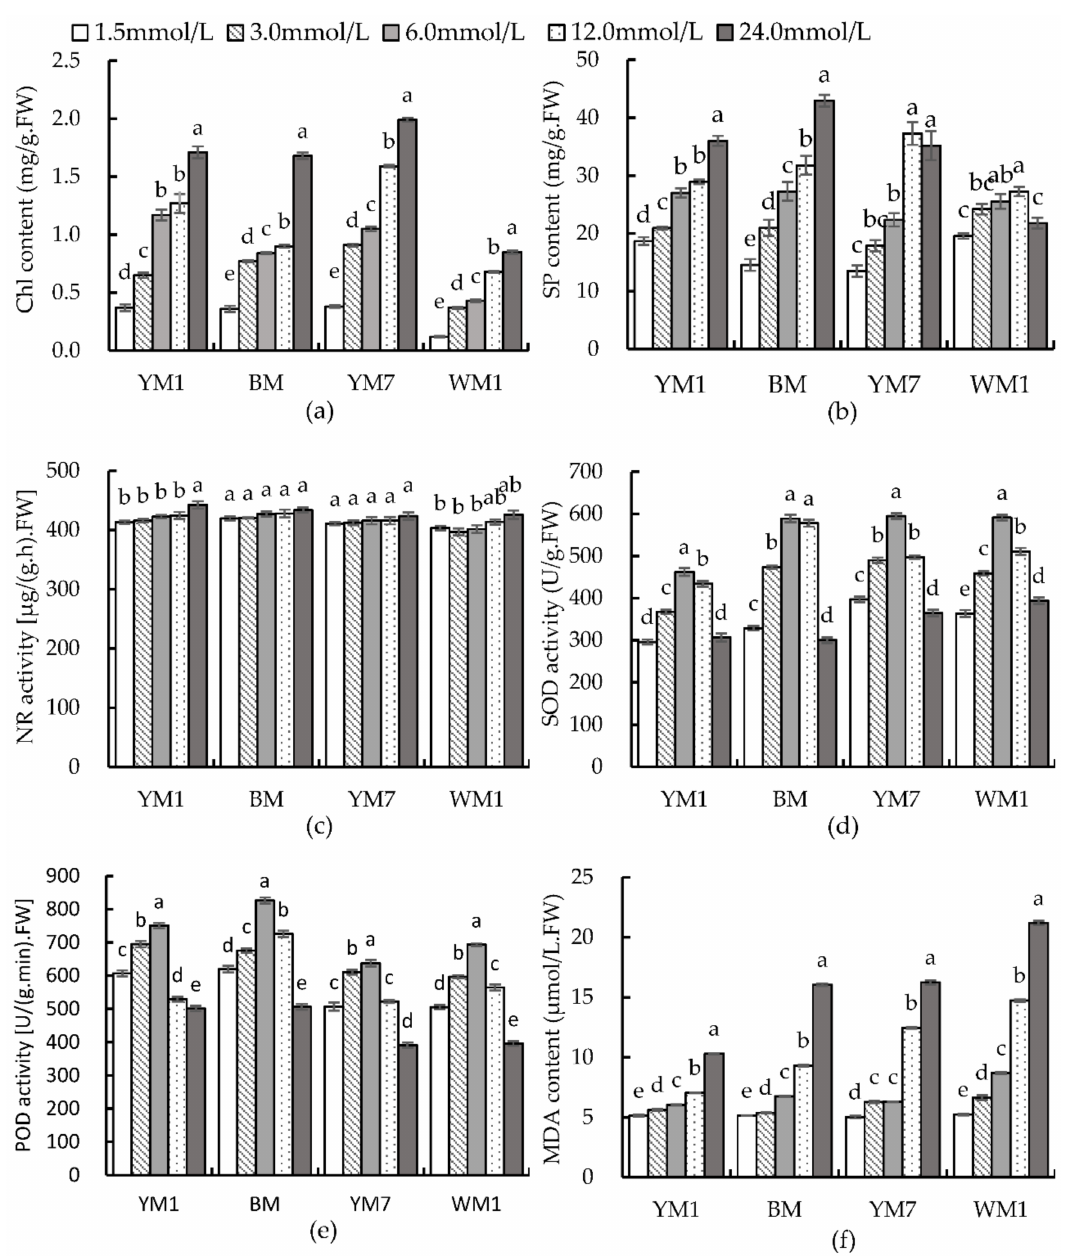
Figure 4. Effect of N treatments on the physiological indicators of hemp leaf. Different letters above the columns within a cultivar represent significant differences in physiological indicators of leaf at p = 0.05. ( a ) The content of Chl of four hemp cultivars under different levels of N. ( b ) The content of SP of four hemp cultivars under different levels of N. ( c ) The activity of NR of four hemp cultivars under different levels of N. ( d ) The activity of SOD of four hemp cultivars under different levels of N. ( e ) The activity of POD of four hemp cultivars under different levels of N. ( f ) The content of MNA of four hemp cultivars under different levels of